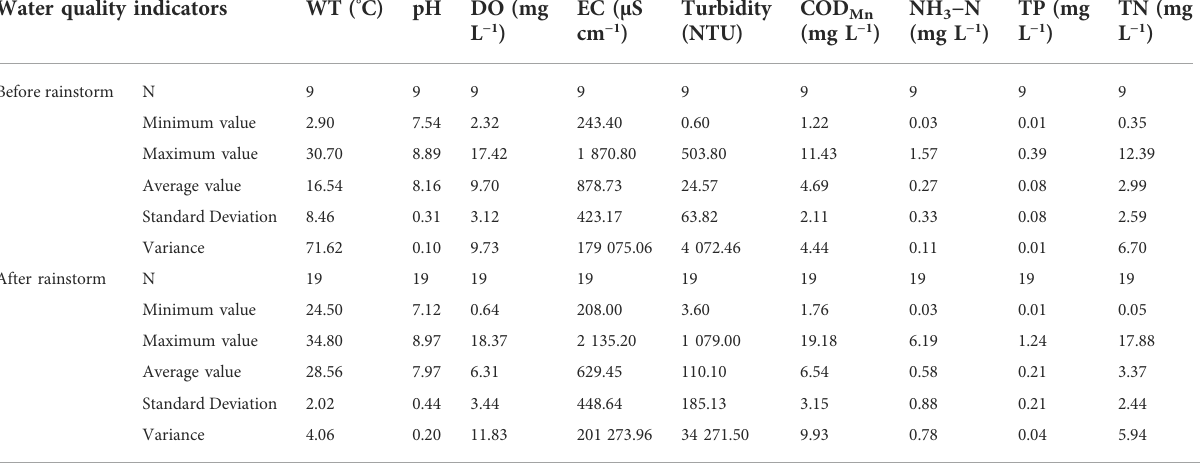
TABLE 2 Statistical description of water quality indicators before and after the rainstorm. Water quality indicators